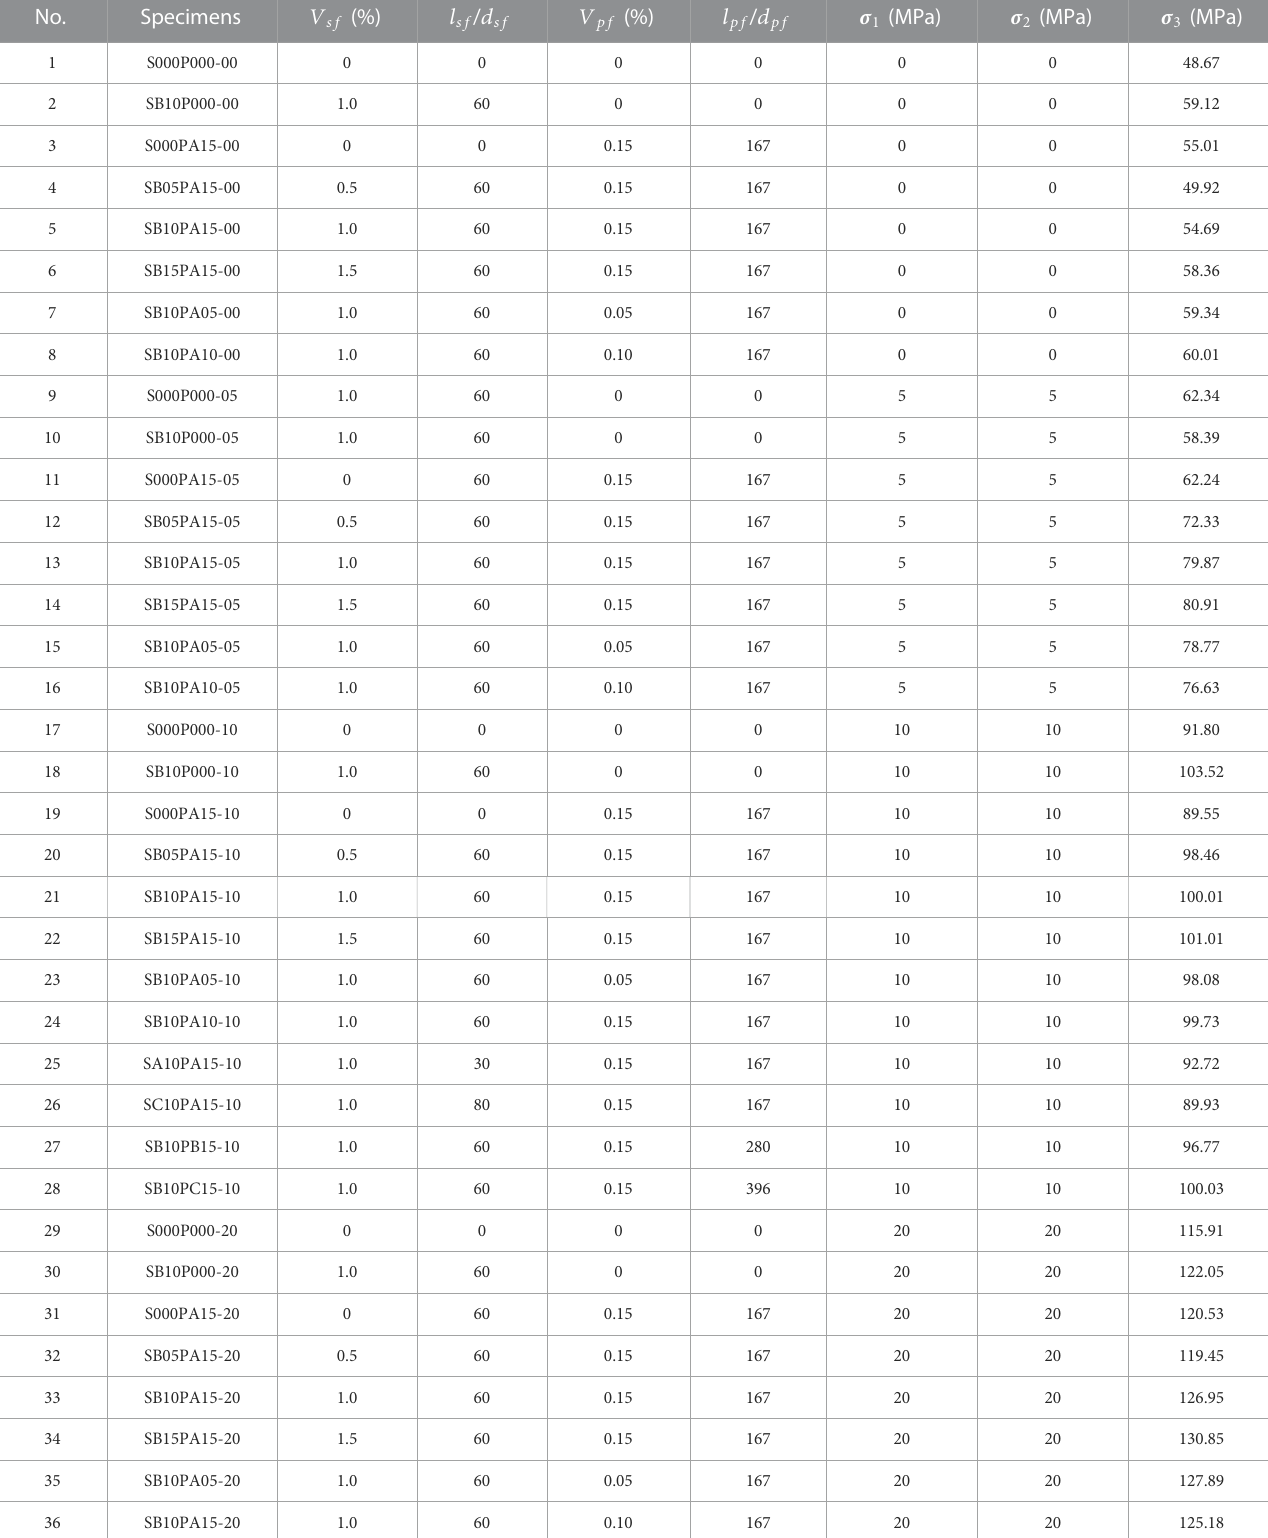
TABLE 3 Axial strength of HFRC under conventional triaxial